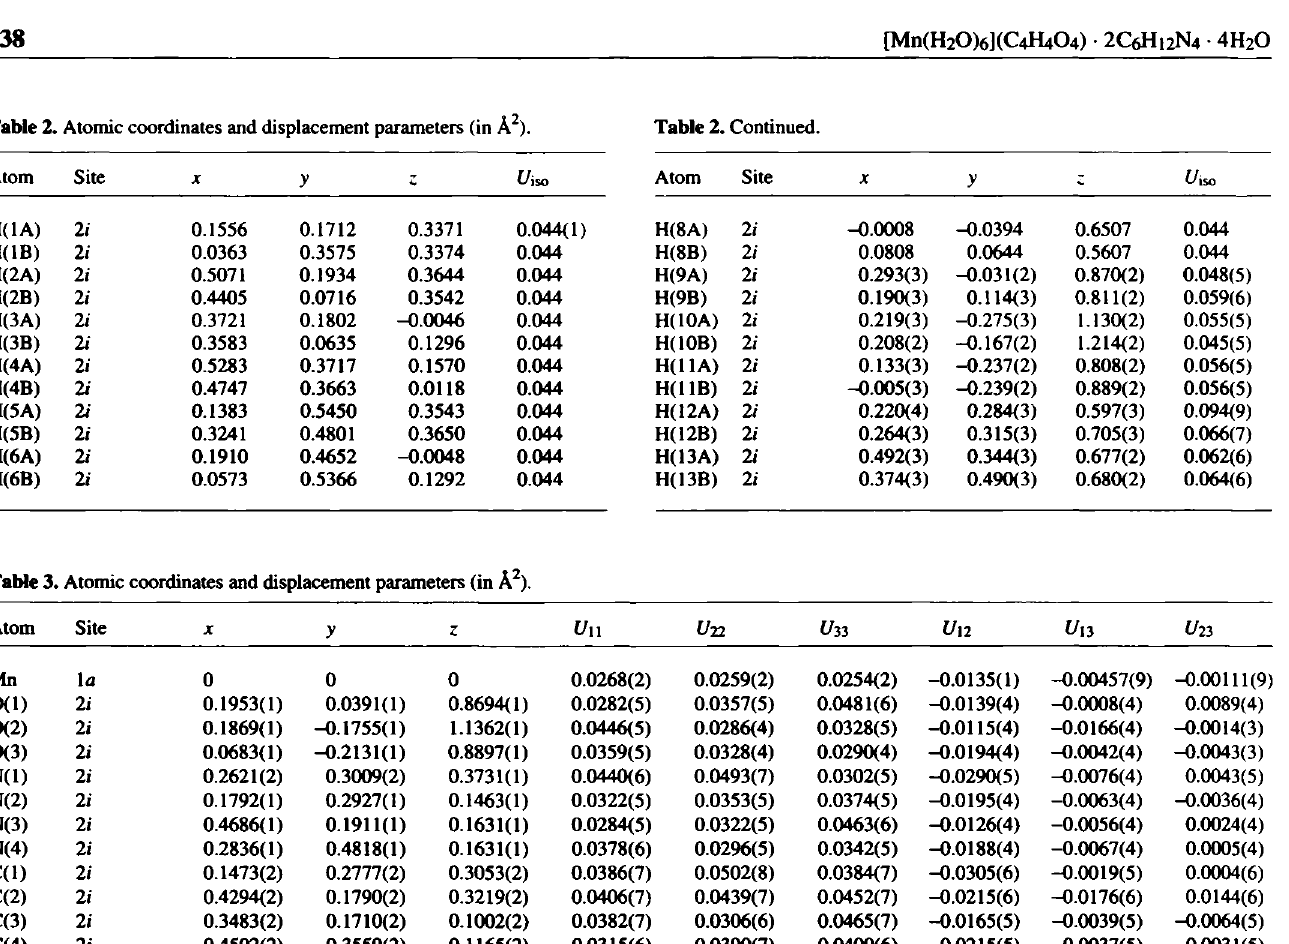
Table 3. Atomic coordinates and displacement parameters (in Â 2